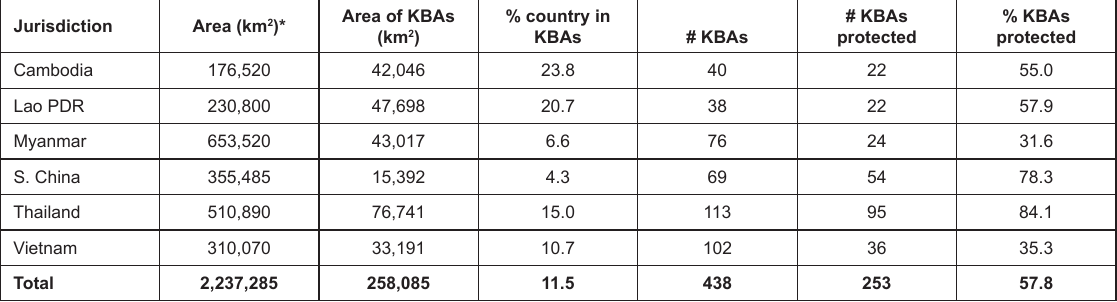
Table 1. Area, number and coverage of KBAs in each country included within the analysis for the Indo-Burma Hotspot